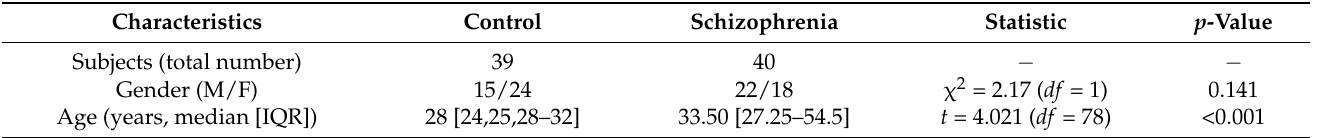
Table 2. Demographic and clinical characteristics of control subjects and patients with SCZ in the Bari